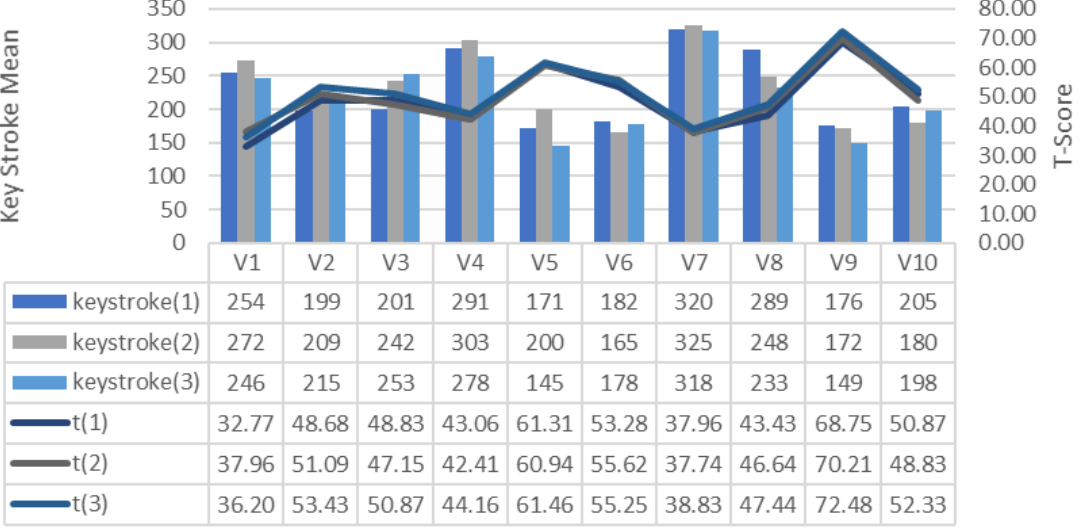
Figure 6. Relationship between the number of keystrokes per round on the track GDES and game performance (T-Score). EEG signals collected during the training process were analyzed for frequency bands and changes in alpha, beta-low, beta-medium, beta-high, delta and theta bands